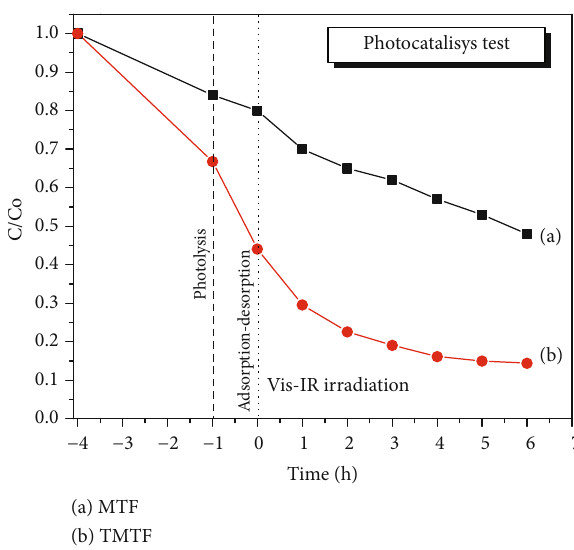
Figure 8: Adsorption-desorption test between Rh B solution in the presence of di ff erent photocatalyst. The test was carried out in the dark.